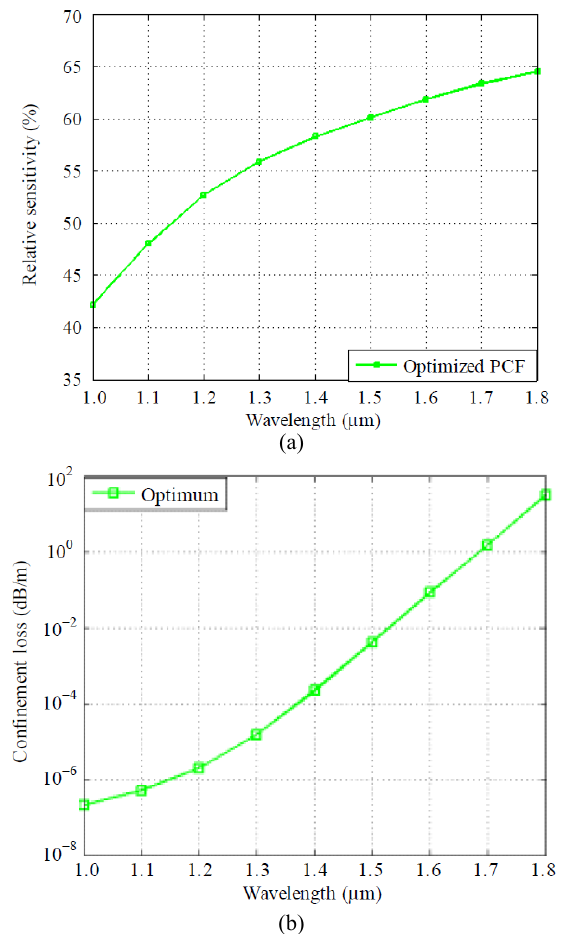
Fig. 3 Relationship between: (a) relative sensitivity versus wavelength and (b) confinement loss versus wavelength curve for the proposed H-PCF for optimized parameters: Λ = 3.00  m, Λ c = 1.08  m, d = 2.85  m, d c = 0.774  m, and d c 0 = 1.08  m.